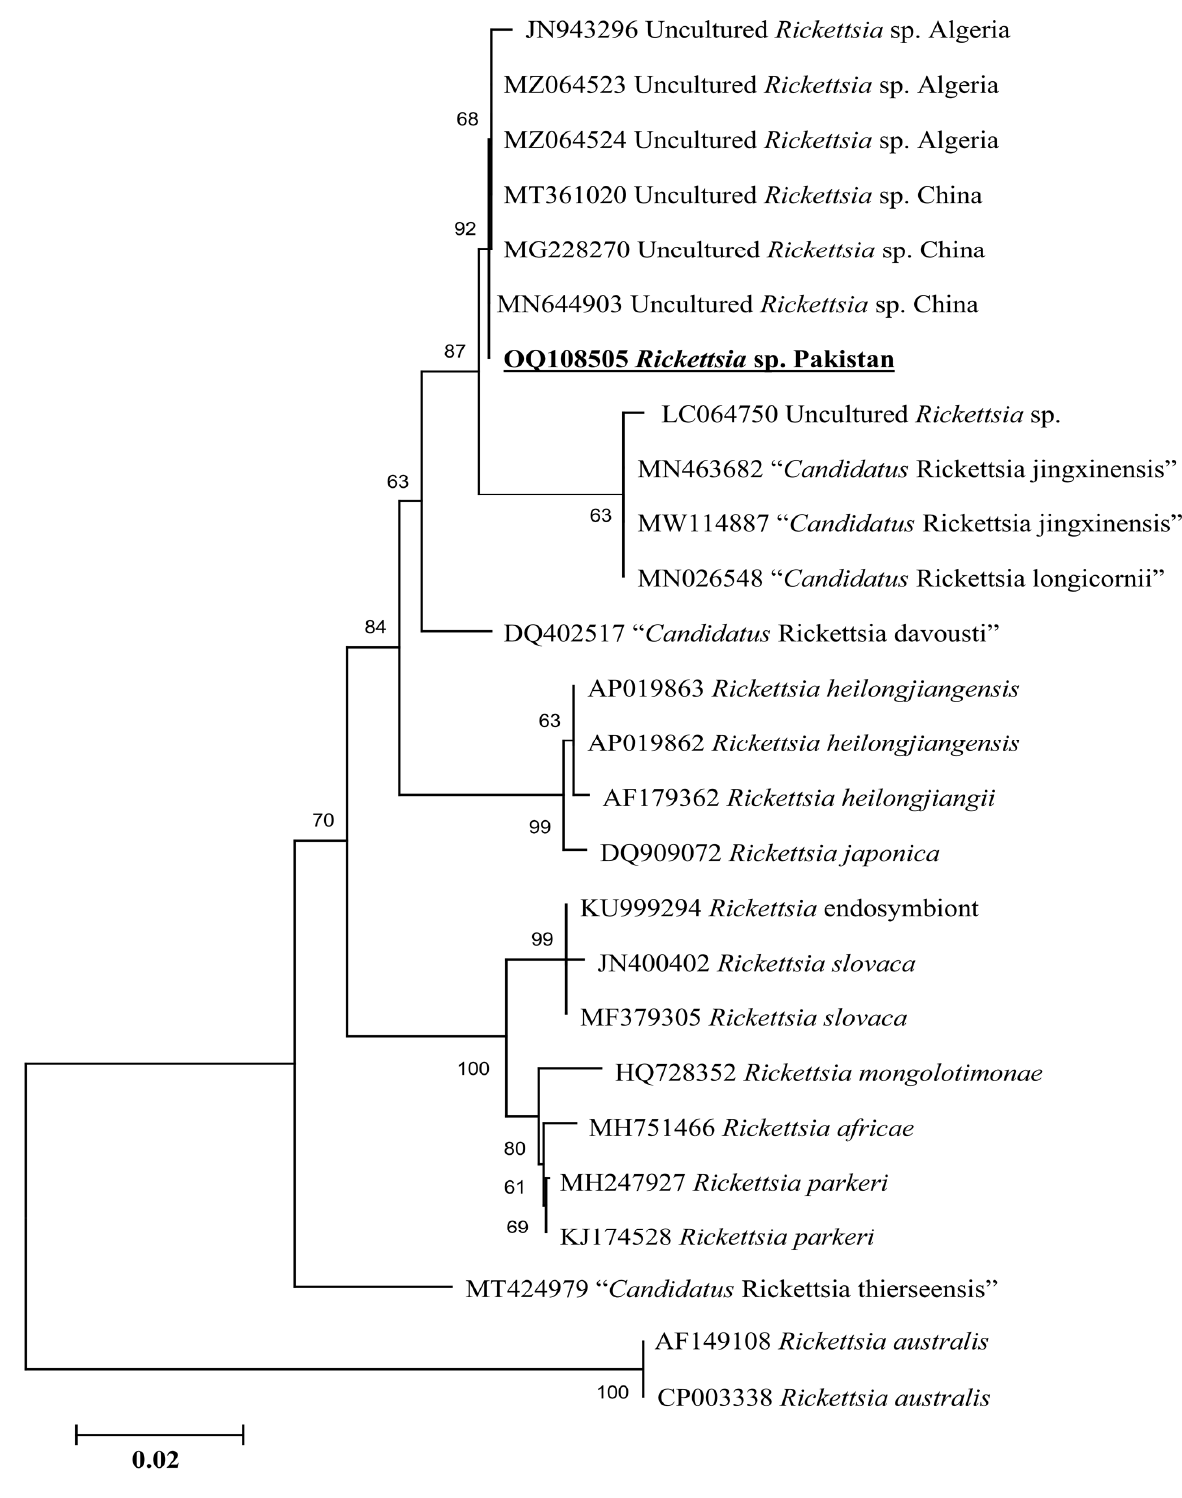
Figure 6. Neighbor ‐ Joining phylogenetic tree based on ompA sequences of a Rickettsia sp. The ompA sequences of R. australis were employed as an outgroup. All sequences have been denoted by their GenBank accession numbers, followed by species name and country name. The bootstrap values (1000 ‐ replications) are shown at each node. The sequence (OQ108505) of the present study has been marked with bold and underlined fonts.